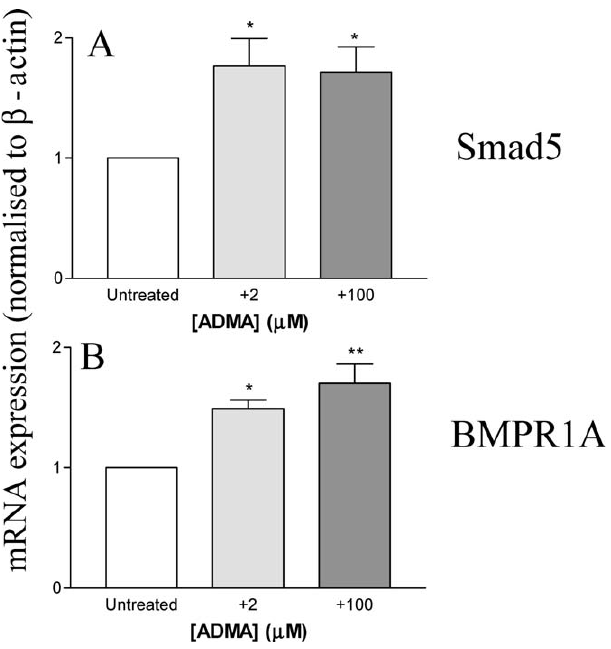
Figure 6. Genes Involved in BMP Signalling are Altered by ADMA Smad5 (A) and BMPR1A (B) are elevated in HCAEC following 24-h treatment with ADMA (2 and 100 l M), as shown by Northern blotting where mRNA was corrected for differences in b -actin mRNA expression (* p , 0.05; ** p , 0.01, where n ¼ 4). DOI: 10.1371/journal.pmed.0020264.g006